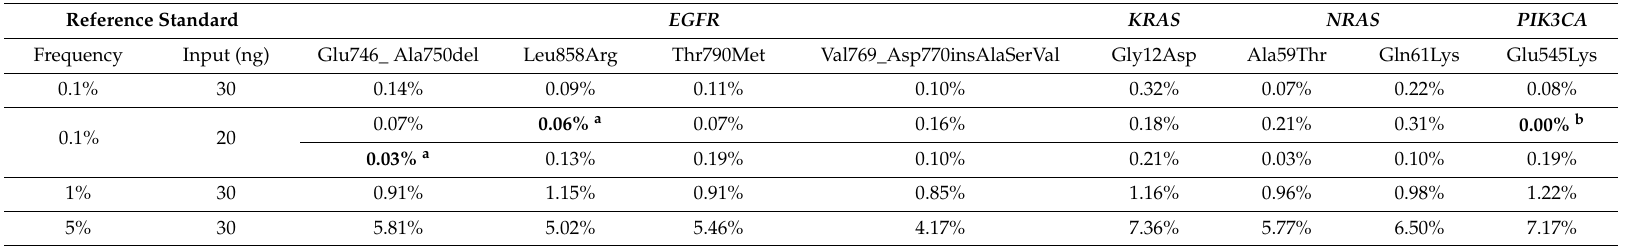
Table 1. Frequency variants detected in Multiplex cfDNA Reference Standard for each of the 8 hotspot variants occurring in 4 genes ( EGFR , KRAS , NRAS and PIK3CA ). In bold, variants filtered out by the bioinformatic pipeline in EGFR gene and a failed call in PIK3CA